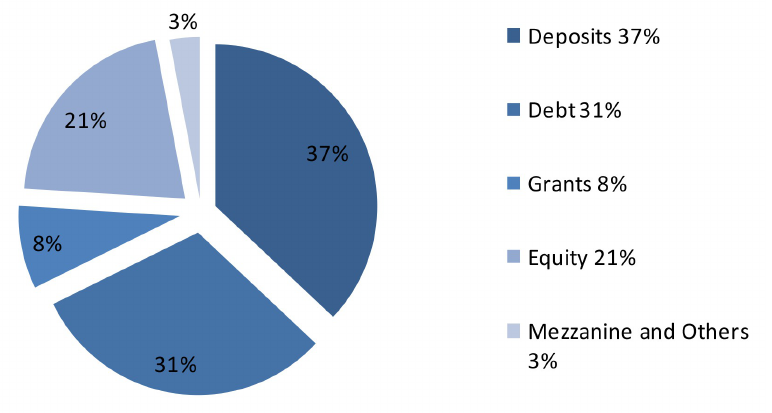
Figure 2. Committed Funding Amount by Instrument for MFIs (average) (CGAP, 2010)